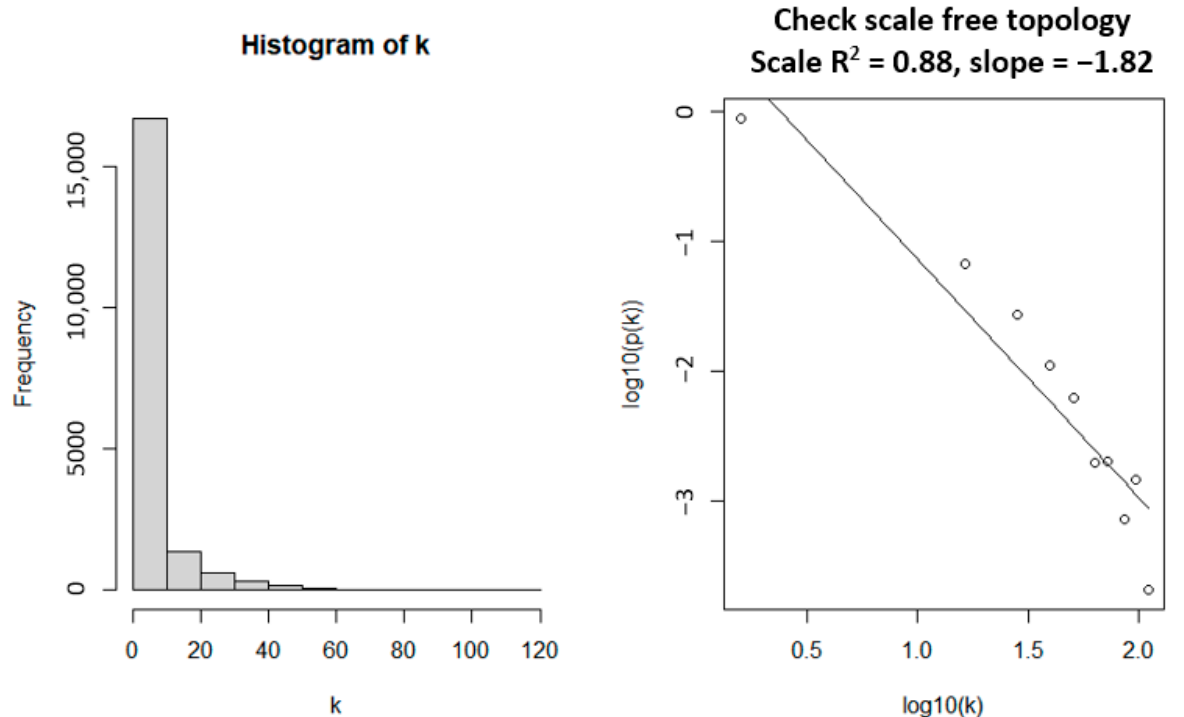
Figure 3. Power law distribution graph to verify scale-free topology of the network.